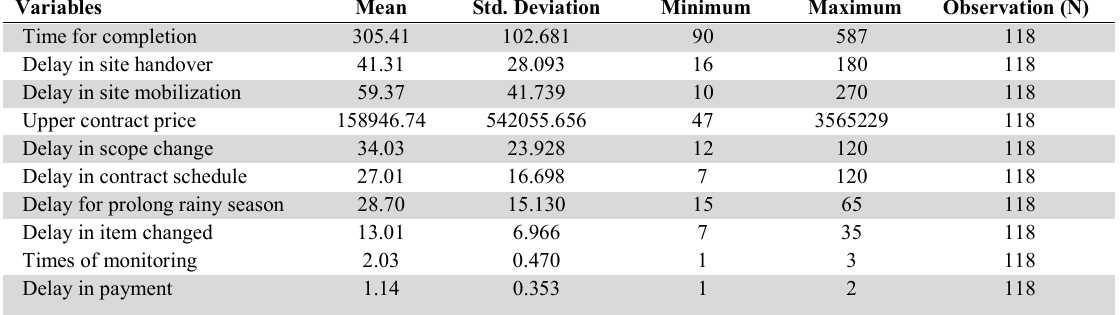
Descriptive statistics of dependent variable time for completion